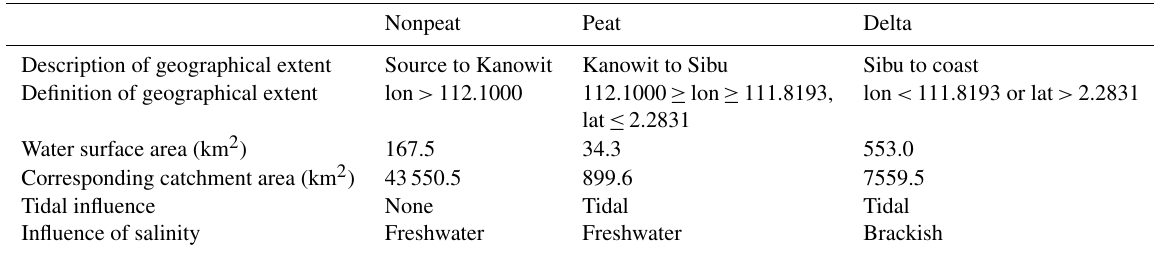
Table 1. Definition of the different areas considered in this study. Nonpeat Peat Delta Description of geographical extent Source to Kanowit Kanowit to Sibu Sibu to coast Definition of geographical extent lon > 112.1000 112.1000 ≥ lon ≥ 111.8193, Water surface area (km 2 )